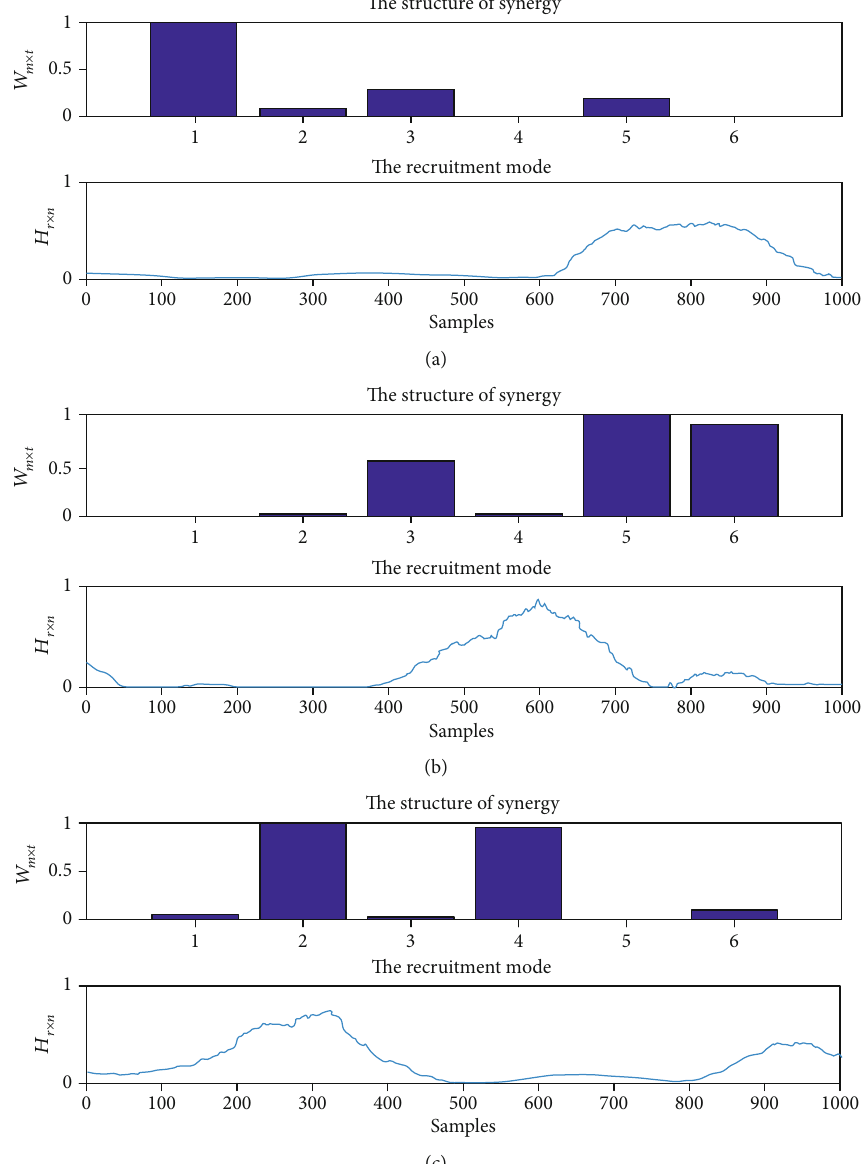
Figure 6: The typical results of muscle synergies of upper limbs for healthy subjects during the HRI with clockwise circle-drawing movements. (a) The synergy pattern and activation coe ffi cients for the fi rst synergy; (b) the synergy pattern and activation coe ffi cients for the second synergy; (c) the synergy pattern and activation coe ffi cients for the third synergy. The structure of synergy represents the synergy pattern of muscle synergies, and the recruitment mode represents the activation coe ffi cients of muscle